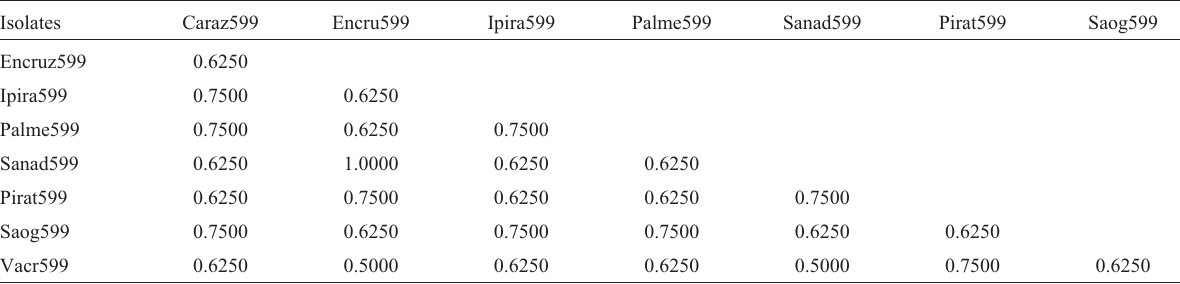
Table IV - Drechslera teres similarity matrix coefficients based on colony morphology only.